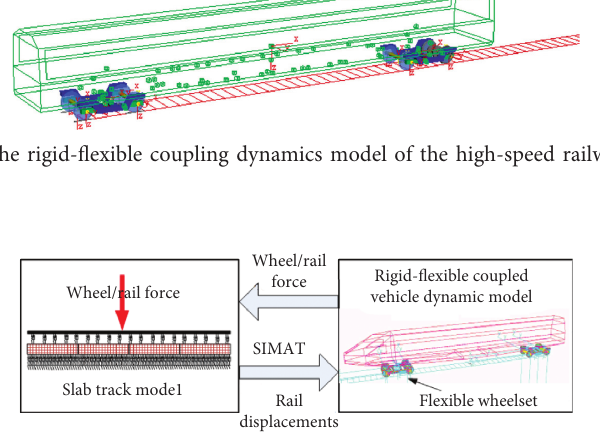
Figure 5: Vehicle-track rigid-flexible coupling dynamics